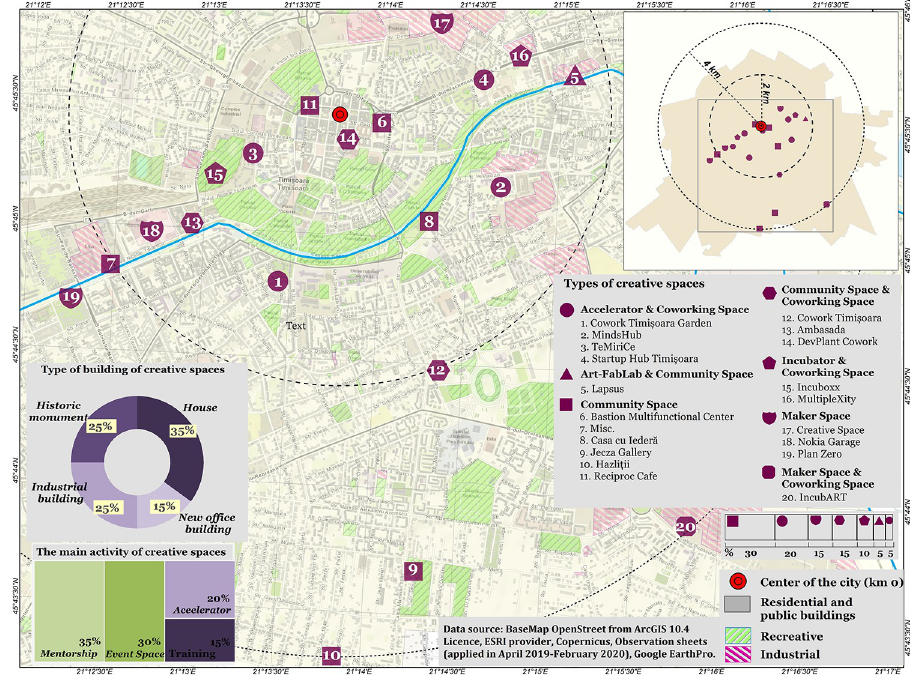
Fig 2. Sampling locations of creative spaces in Timi ş